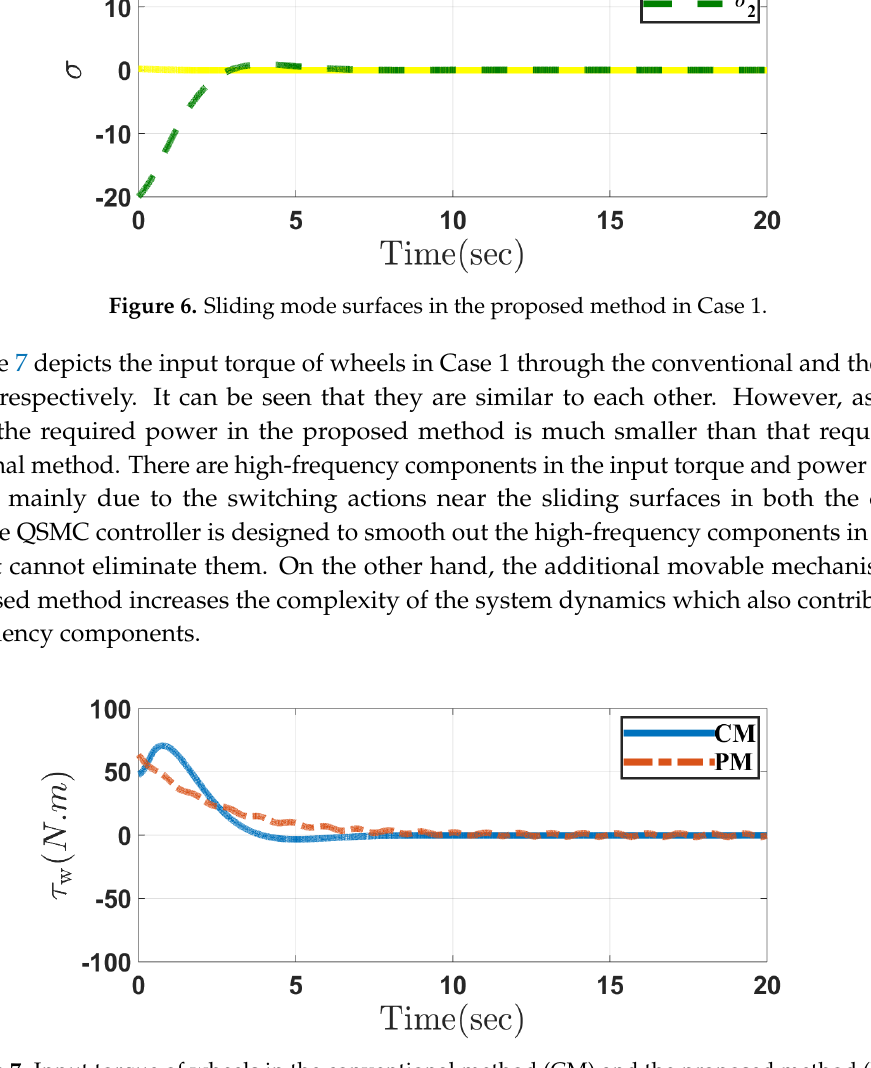
Figure 7. Input torque of wheels in the conventional method (CM) and the proposed method (PM) in Case